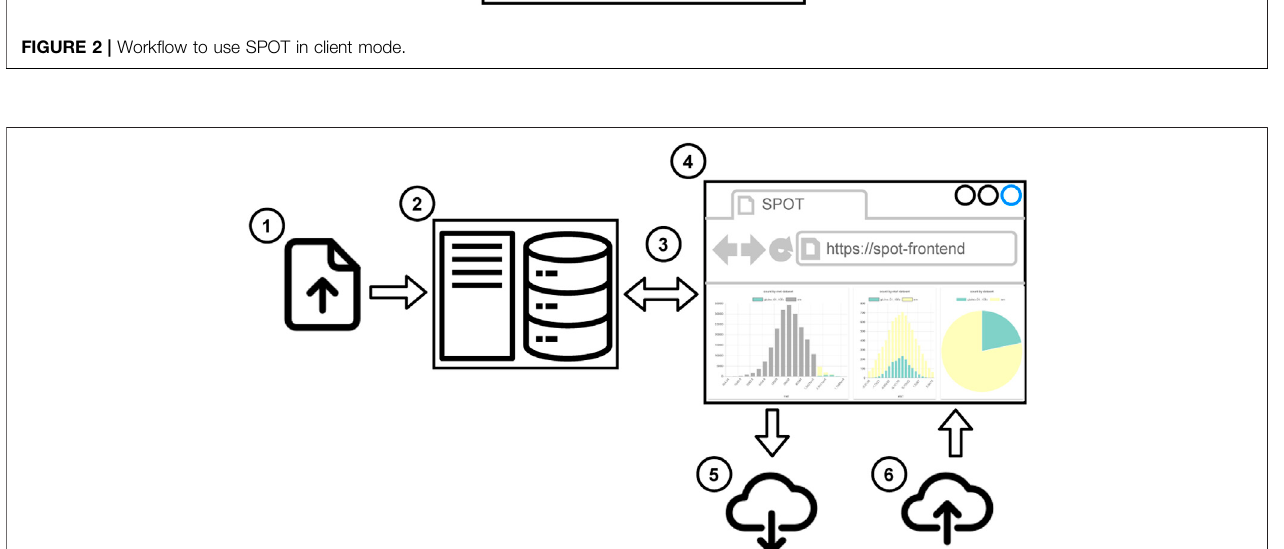
FIGURE 3 | Work fl ow to use SPOT in server